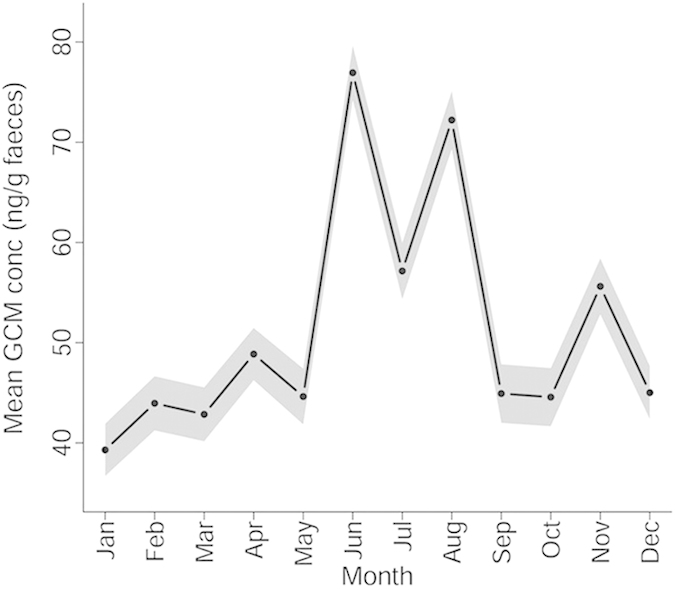
Mean monthly glucocorticoid metabolite concentration in female elephants aged 17-55.We used a total of 354 points for 37 reproductive-aged females. The solid line indicates mean predicted values for monthly glucocorticoid metabolite concentration (GCM). The shaded area indicates standard error around the mean values.